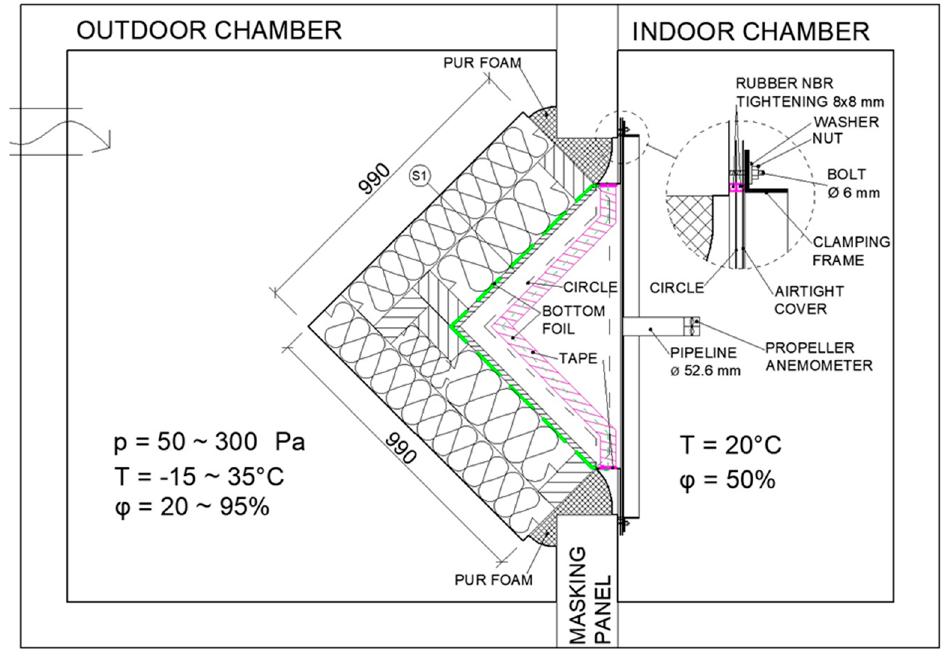
Figure 5. Horizontal cross section of the specimen after installation.